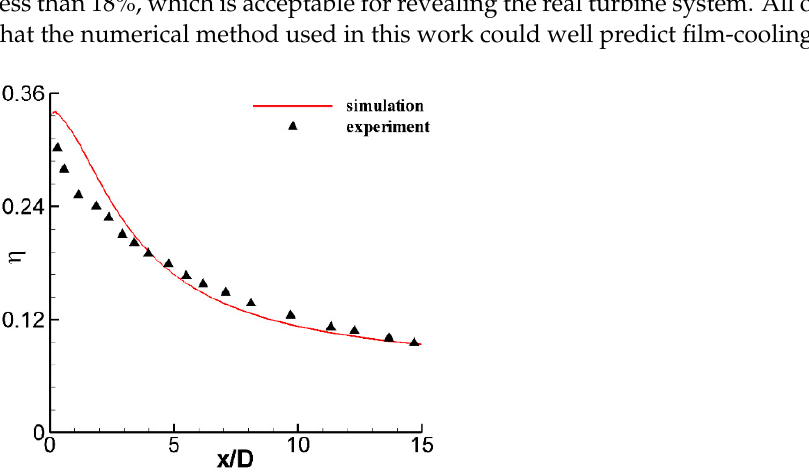
Figure 3. Comparison of spanwise-averaged film cooling effectiveness η between the numerical results and the experimental data.